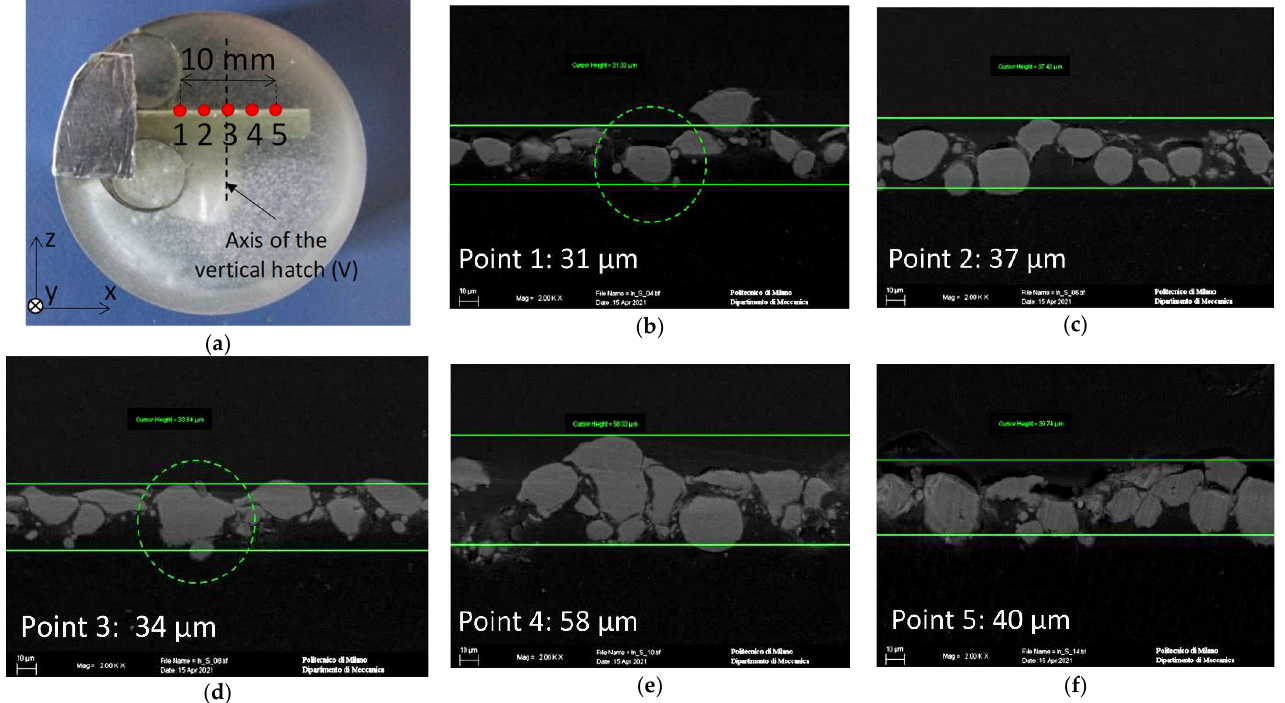
Figure 8. Specimen S1 , through-thickness analysis: ( a ) points location; ( b–f ) SEM-magnified images of the five points.